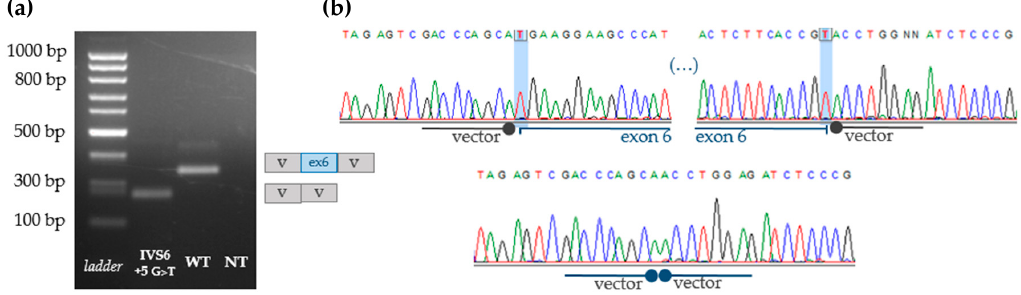
Figure 4. RT-PCR amplification and Sanger sequencing of WT and mutant splicing reporter minigenes using vector-specific primers. The results of RT-PCR analysis using vector specific primers are shown along with a diagram of the transcripts obtained in Hep3B cells after 24 h of incubation ( a ) and their sequencing results depicted in electropherograms ( b ). c.1213+5G>T [IVS6+5G>T]: mutant minigene; WT: wild-type; NT: non-transfected.